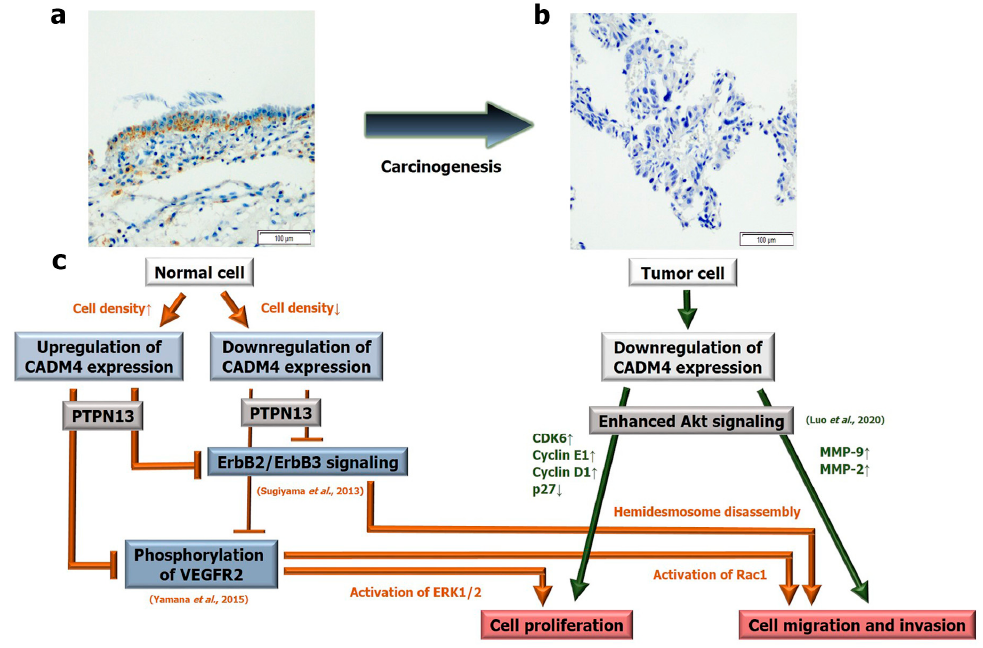
Figure 3. ( a ) Normal cells of the gallbladder mucosa showed relatively uniform expression of CADM4 with weak to moderate intensity (×200). ( b ) Loss of or reduced CADM4 expression was identified in gallbladder cancer (GBC) tissues (×200). ( c ) Schematic representation of mechanisms by which regulation of CADM4 expression in normal and tumor cells contributes to cell proliferation, migration, and invasion.